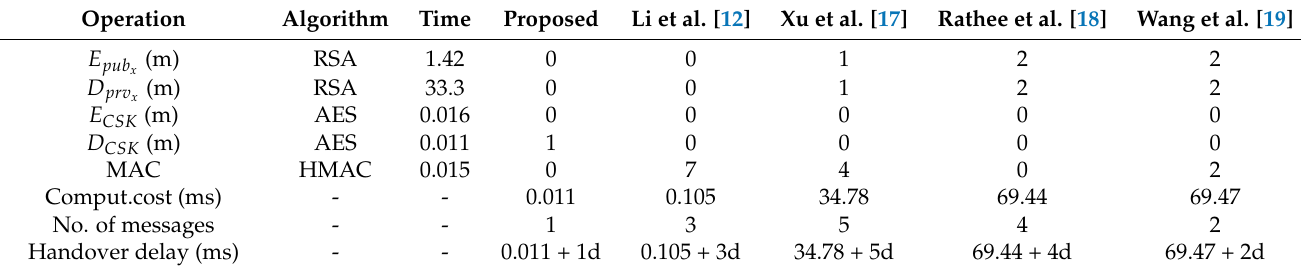
Table 4. Simulation results during handover process.